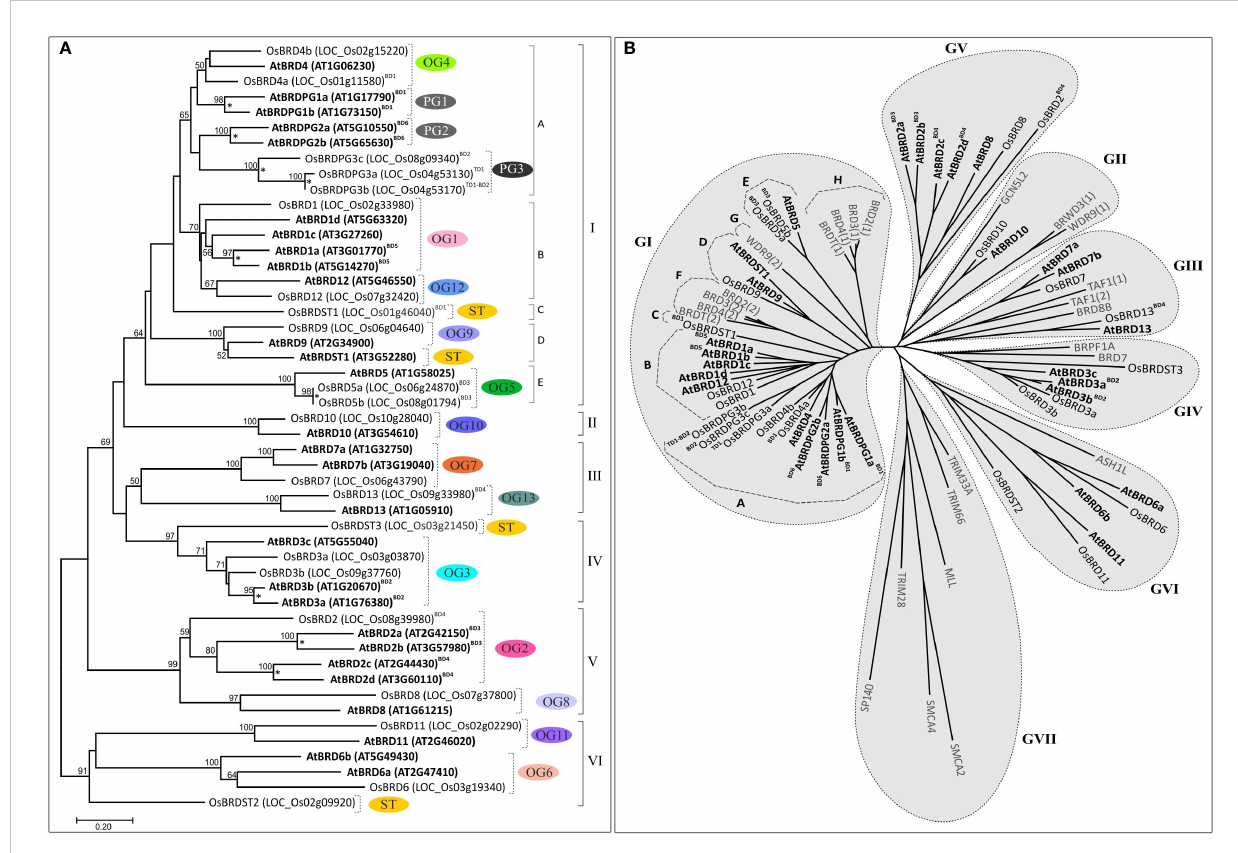
FIGURE 9 (A) Neighbor-joining phylogenetic tree based on the bromodomain (BRD)-regions of A. thaliana and O. sativa Brd - homologs (including the block and tandem duplicates) generated by MEGA-X software. Major clusters are indicated by Roman numerals (I-VI), while sub-clusters are shown by letters (A-E). The ortholog group (OG), paralog group (PG) or singleton category (ST) designation is also indicated. Numbers at the nodes indicate bootstrap values (in %, for 500-replicates), and taxa names (AtBRDs: bold font, OsBRDs: regular font) include Brd-designation used, locus numbers (in parenthesis), and type of duplication events (BD: block duplication; TD: tandem duplication). ‘ * ’ Indicate the gene duplication event in the species. (B) Radiation tree of the BRD-regions of A. thaliana (AtBRDs: bold font style), O . sativa (OsBRDs: regular font style), and some representative human BRD-homologs (BRD2-4, BRD8B, BRDT, WDR9, TAF1, BRWD3, BRPF1A, BRD7, GCN5L2, ASH1L, TRIM33A, TRIM66, MLL, SMCA2, SMCA4, TRIM28, SP140, shown in grey font style), placed into seven major groups (GI-GVII) and subgroups (A-H). Designation ‘ BD ’ and ‘ TD ’ indicated block and tandem duplication events, while numerals in parenthesis (1/2) indicate two different domains of the dual-BRD-containing